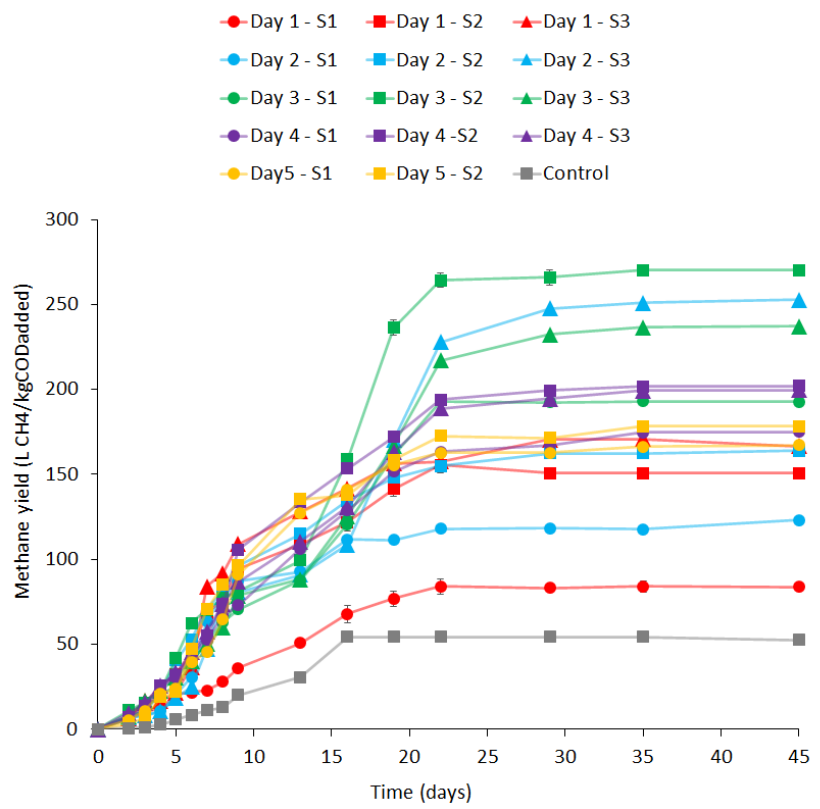
Figure 1. Effect of temporal variation in chemical composition on methane yields during the anaerobic digestion of rendering plant wastewater incubated in batch assays at 37 ◦